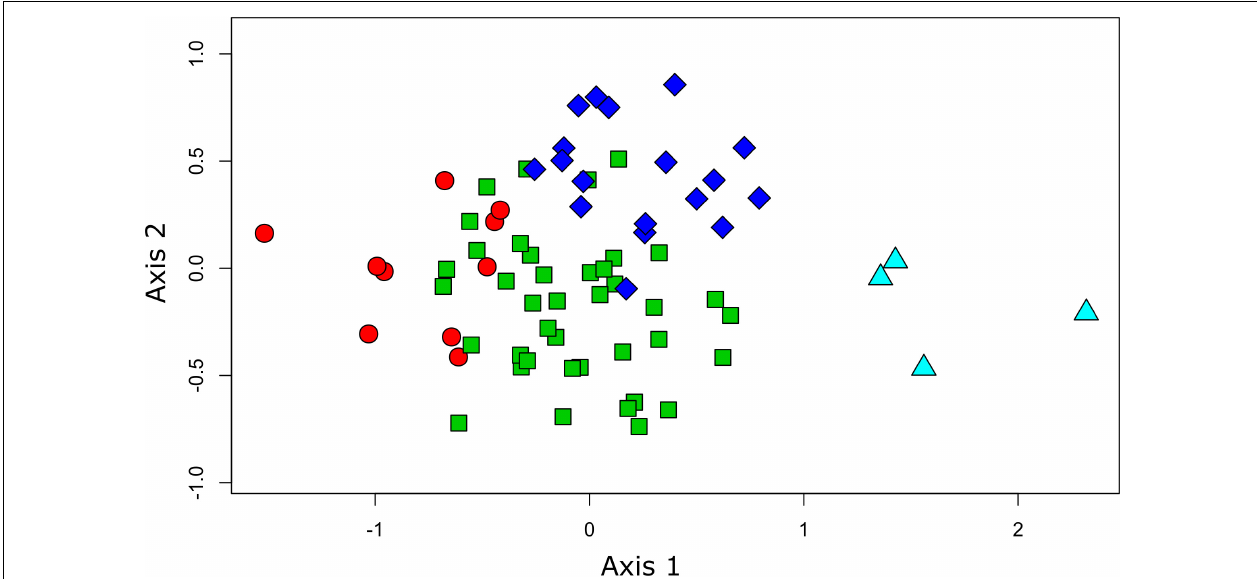
FIGURE 3 | Plot of sampled sites showing the results from the NMDS ordination (1st and 2nd axis) overlaid on the results from the clustering analysis. The different colors and shapes of the sites correspond to the different groups found ( Figure 2 ) (circles: Humboldt, triangles: Easter I, squares: Juan Fernández, and diamonds: Desventuradas).